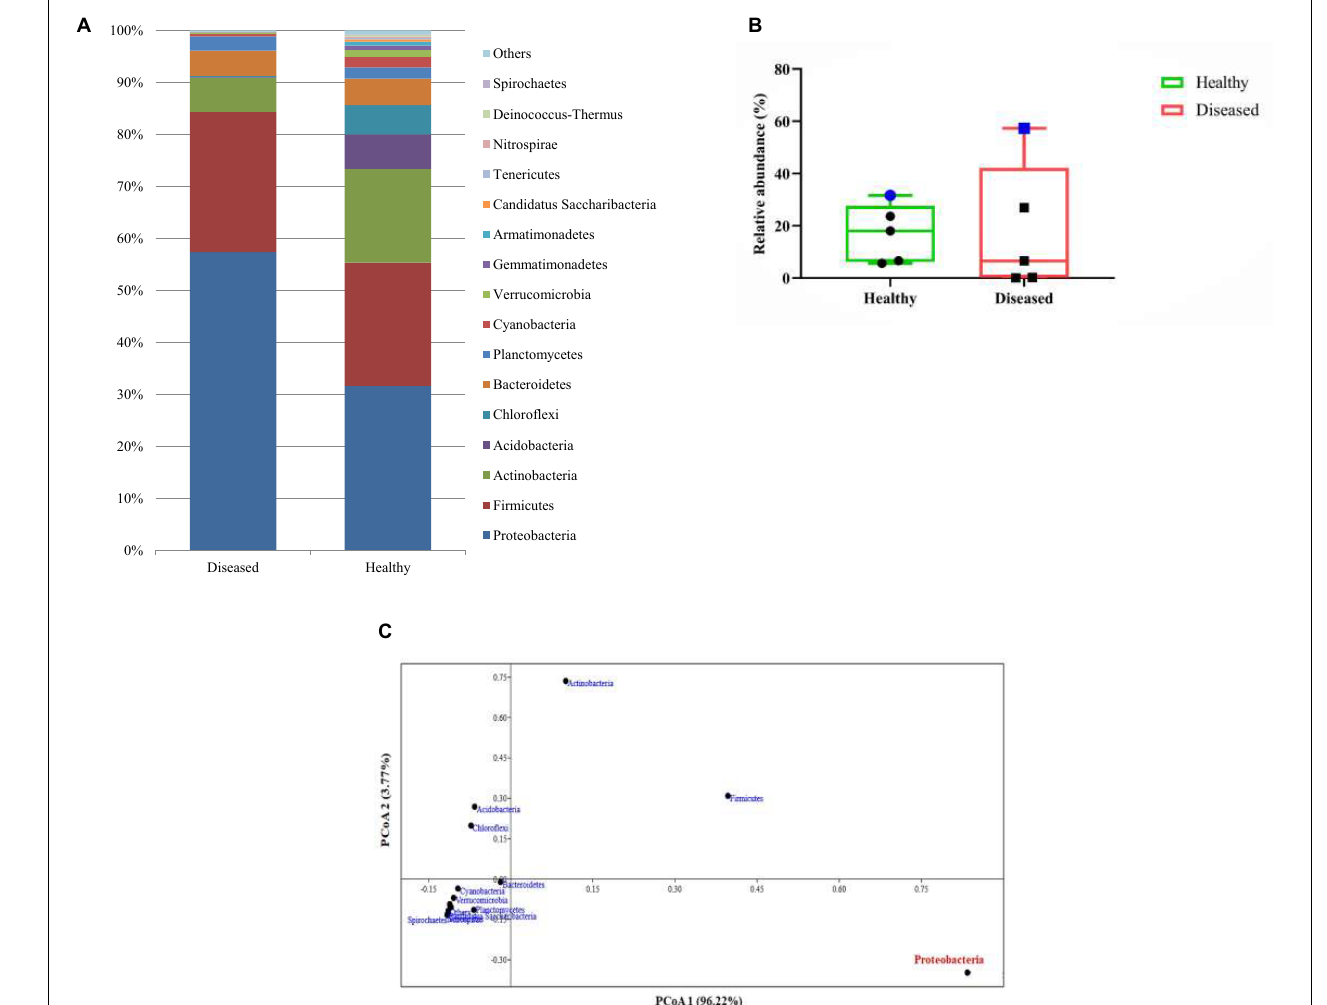
FIGURE 2 | (A) Relative abundance (%) identified based on the metagenomic reads of major bacterial communities at the phylum level; (B) Box and whisker plots of relative abundance of the top 5 abundant phyla. Blue symbol represents the variation of proteobacteria abundance in healthy and diseased coral; (C) Principal coordinate analysis (PCoA) based on the abundance of bacterial